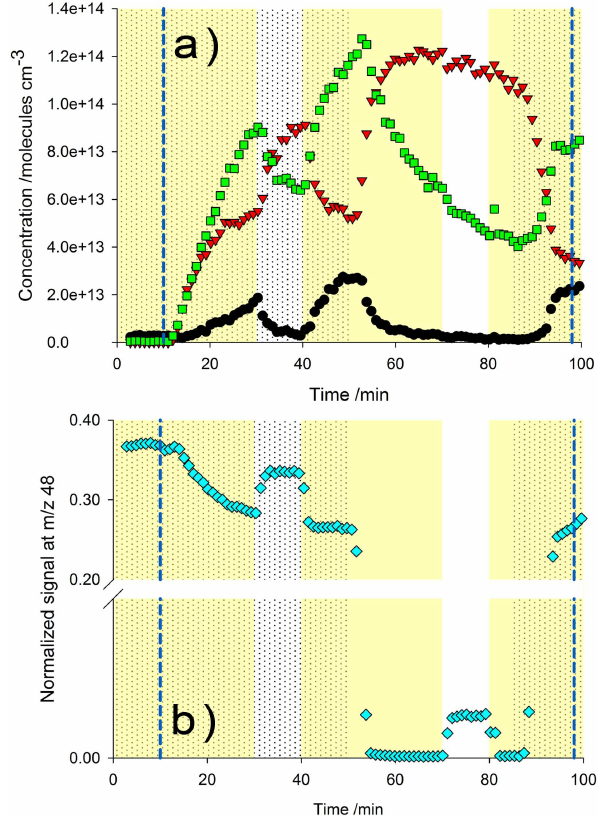
Fig. 4. Time traces of (a) dihalogen concentrations – Br 2 (red trian- gles), Cl 2 (black circles) and BrCl (green squares); and (b) ozone concentrations (light blue diamonds) during an experiment in which an additional flow of Br 2 (g) was delivered to the sample from a glass manifold (in the period of time indicated by the vertical blue dashed lines). The yellow areas indicate time periods during which the sample was illuminated. The dotted areas indicate time periods during which the ozone generator was switched on ([O 3 ] ∼ 1 × 10 14 moleculescm − 3 ). The experiment was run under BASE scenario conditions except high purity NaCl(s) (Br − <0.001 wt%) was used to prepare the solution. Each point represents the average of a 1min time bin (30 data